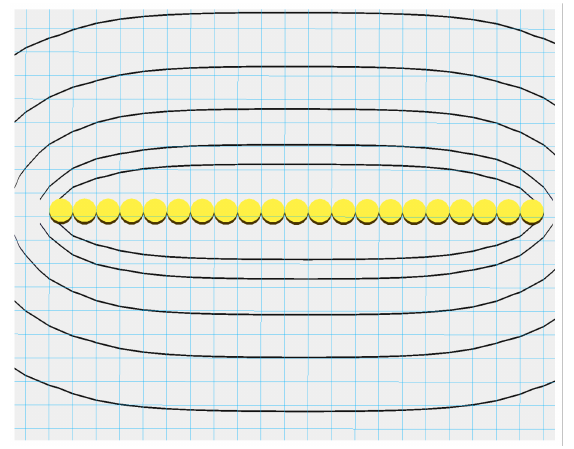
Figure 5. Pressure Iso-Line for Infinite Number of Source Points in Parallel.